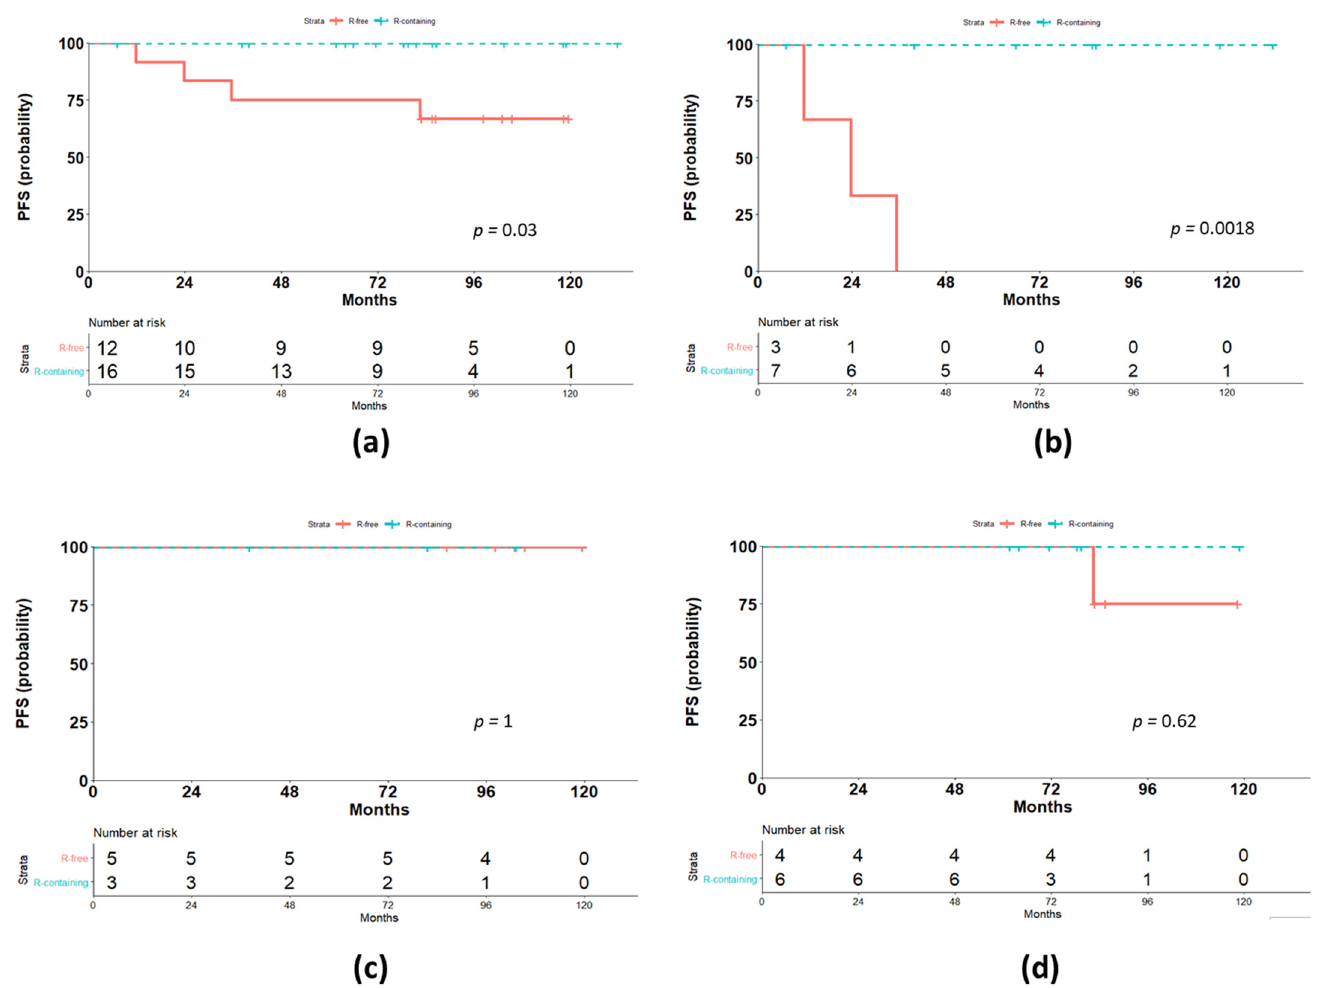
Figure 1. Outcome according to the treatment protocol. ( a ) Comparison of progression-free survival (PFS) for the two treatment groups, Rituximab-containing (R-containing) and Rituximab-free (R-free); ( b ) comparison of PFS for advanced- stages; ( c ) comparison of PFS for early unfavorable stages; ( d ) comparison of PFS for early favorable